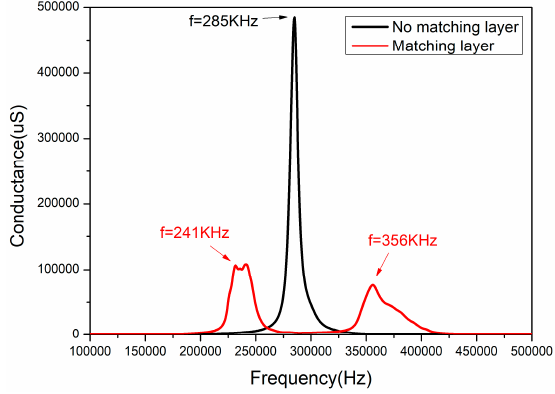
Figure 11. The conductance curve obtained by the actual testing of two models.